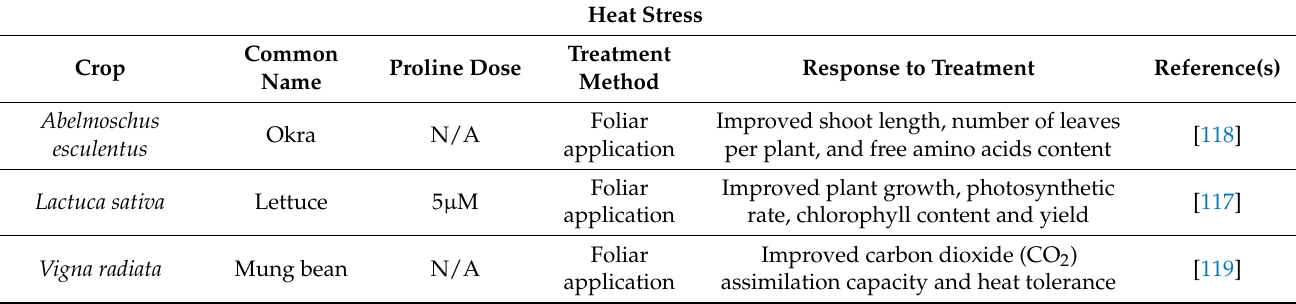
Table 13. Physiological responses of various crops to proline treatment against heat stress.